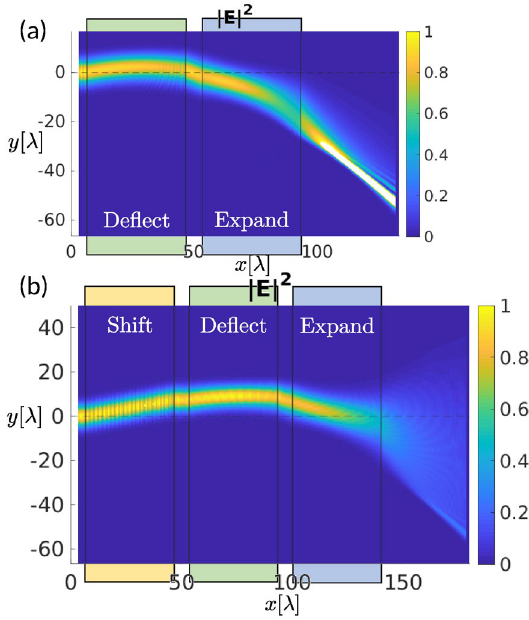
Figure 5. Stacking of building blocks into a multi-layer beam control device. ( a ) Simulated electric field 2 intensity | E | for a double building block device consisting of a deflector and an expander. The beam is efficiently deflected, but expanded non-uniformly, since it does not pass through the centre of the expander block (dashed 2 line). ( b ) Simulated electric field intensity | E | for a triple building block device consisting of a shifter, a deflector and an expander. The shifter pre-positions the beam and thus ensures that it passes through the centre of the expander (dashed line). Uniformity of the expansion is improved. All building blocks in both panels are 40 (cid:31) long with the in-between spacing of 6.67 (cid:31)